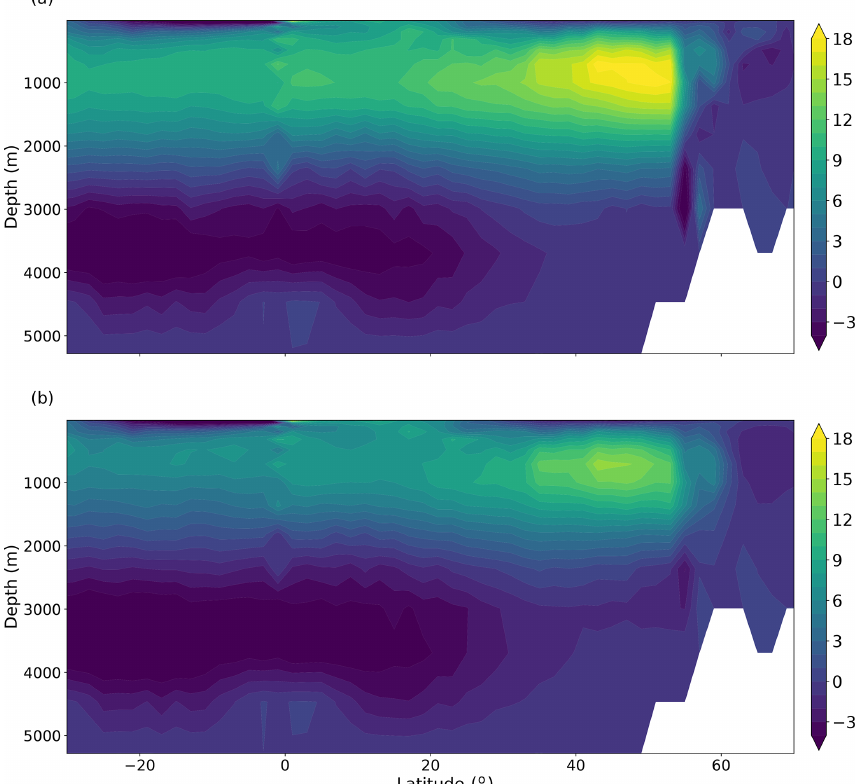
Figure 10. AMOC (Sv) as a function of latitude and depth, averaged over the years 1900–2025 of (a) the L35 integration and (b) the L20